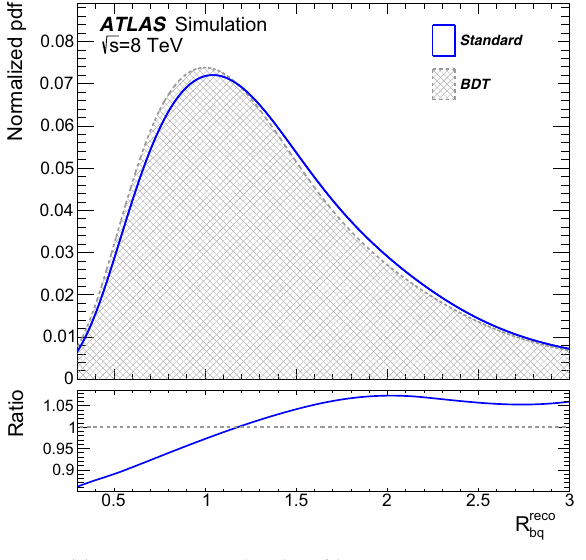
tions are also shown. a shows the reconstructed top quark mass m reco top , b shows the reconstructed W boson mass m reco and c shows the recon- W structed jet- p T ratio R reco